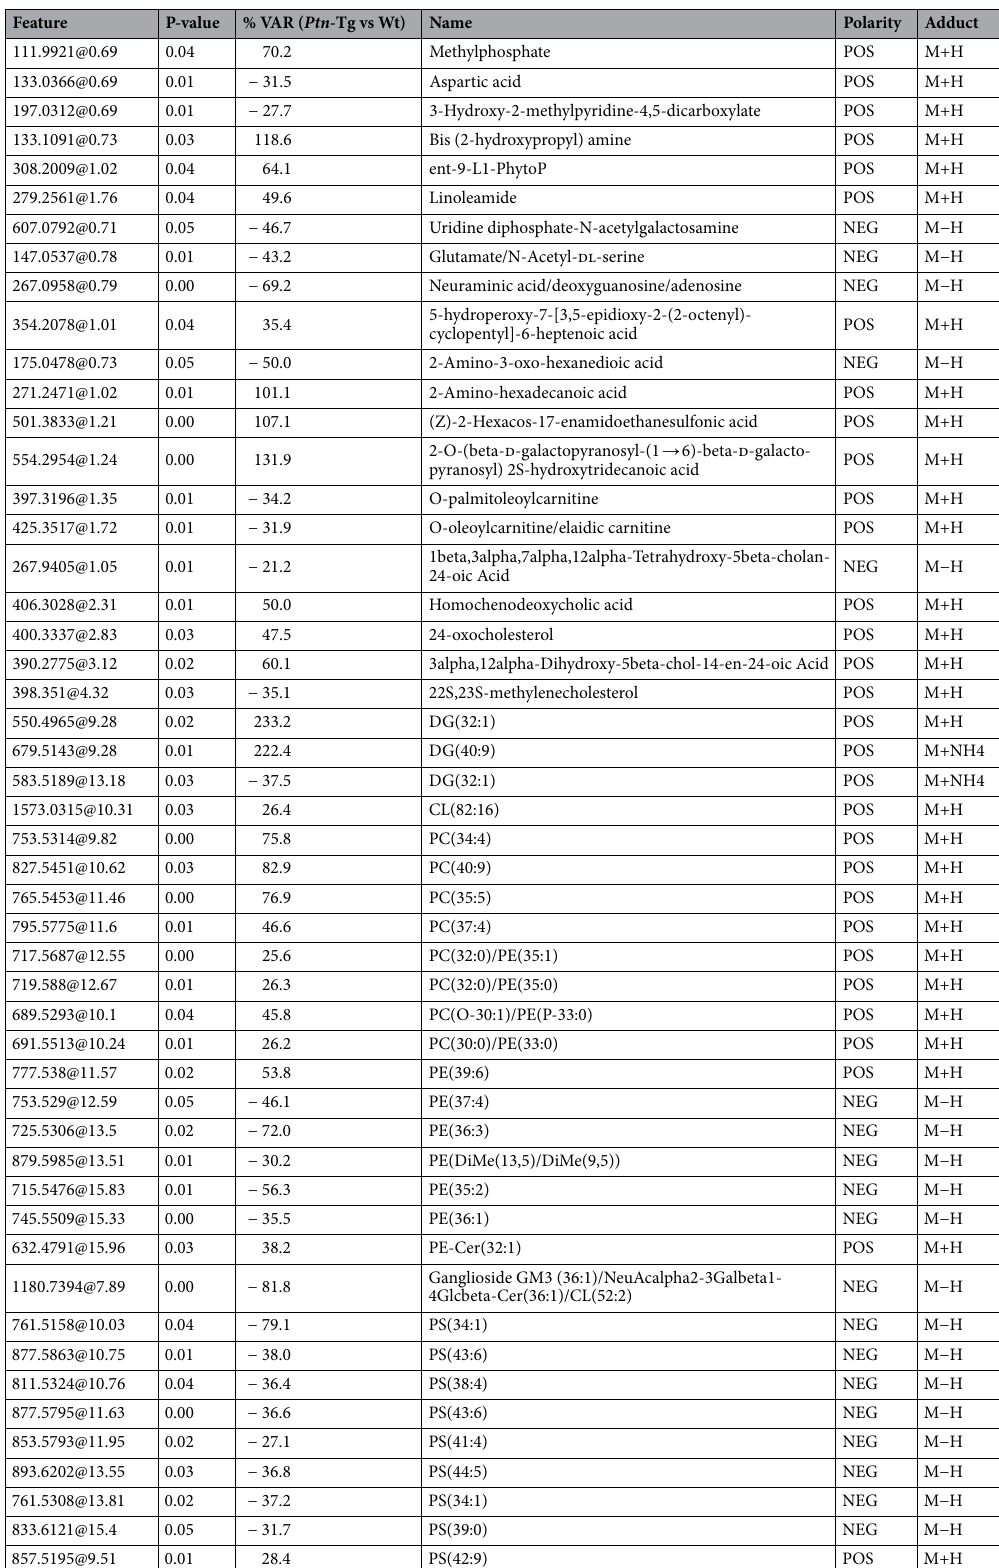
Table 1. Metabolites found to be significant between 6-OHDA-injected Ptn -Tg mice and 6-OHDA-injected Wt